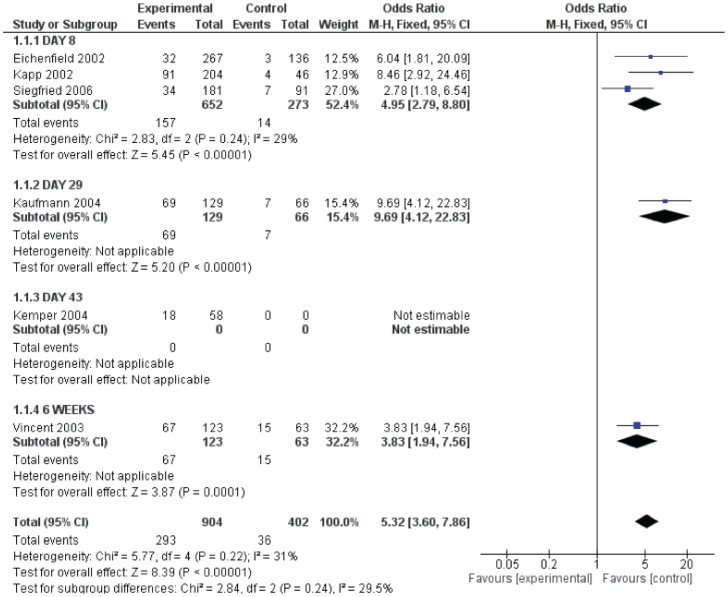
Analysis of reduction in IGA (Pimecrolimus vs vehicle).